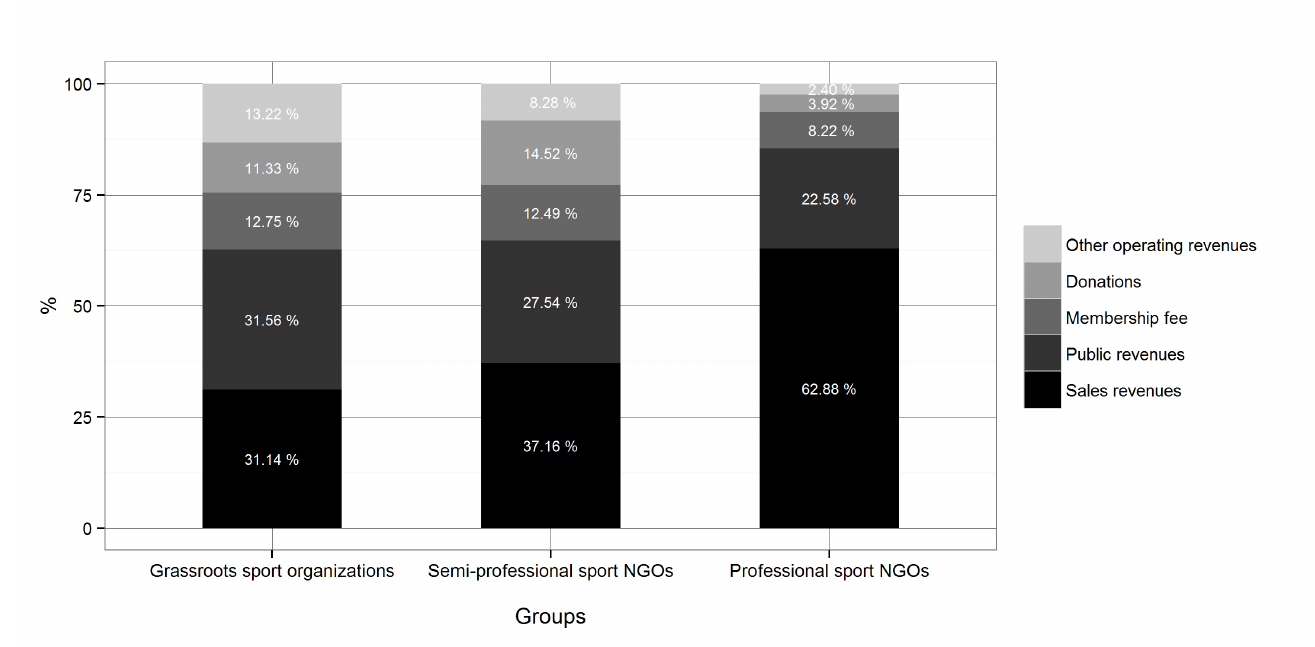
Figure 3. Structure of operating revenues in year 2010 by three groups of sport